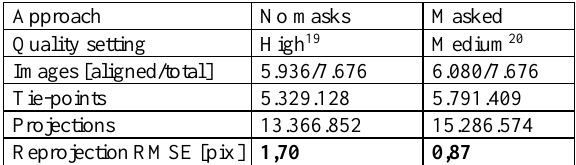
Table 7. Results after the image alignment and camera self- calibration for the same dataset for images with and without masks.